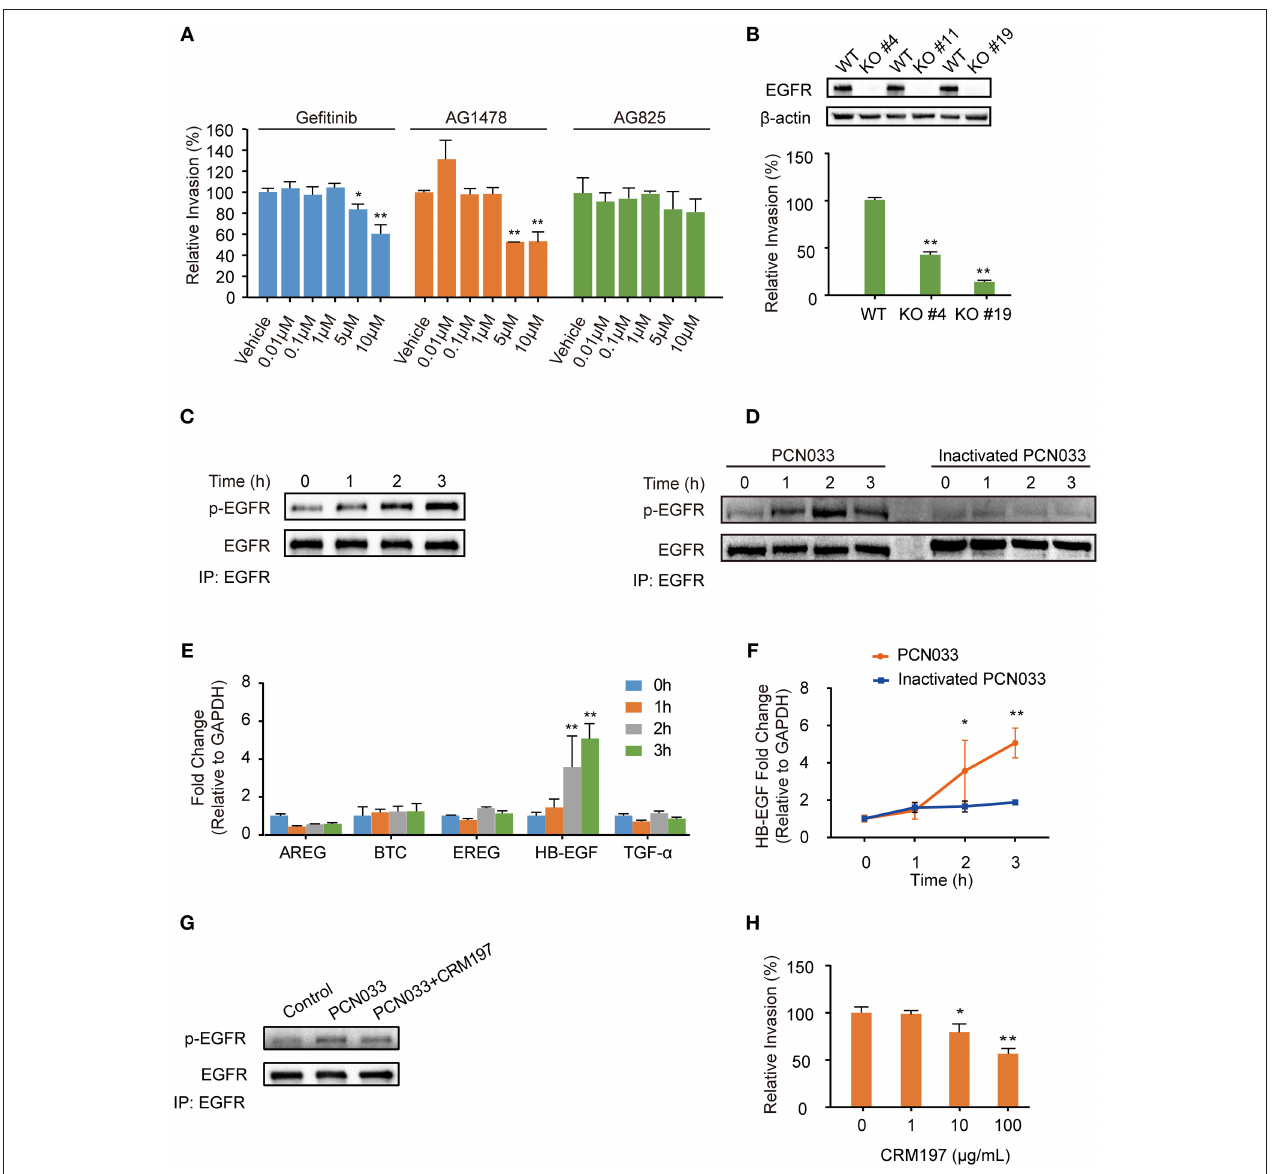
FIGURE 1 | Meningitic E. coli PCN033-induced activation of EGFR contributes to its invasion of hBMECs. (A) Effects of the EGFR inhibitor gefitinib, AG1478 and the analog AG825 on PCN033 invasion of hBMECs. Data represent the mean ± SD of three duplications and are presented here as relative invasion compared with the vehicle control. (B) Verification of successful EGFR KO and its influence on bacterial invasion. (C) Tyrosine phosphorylation of EGFR during the infection. (D) EGFR activation in response to both viable PCN033 and heat-inactivated PCN033 strains. (E) Quantitation analysis of different EGFR ligands in response to PCN033 infection. GAPDH was used as the endogenous control. (F) Comparison of the induction of HB-EGF by the viable and inactivated PCN033 over time. (G) Effect of CRM197 treatment on the PCN033-induced EGFR activation. hBMECs were challenged with PCN033 for 3h. (H) The effect of CRM197 on PCN033 invasion of hBMECs. The results represent the relative invasion percentage compared with the untreated control. * p < 0.05, ** p <